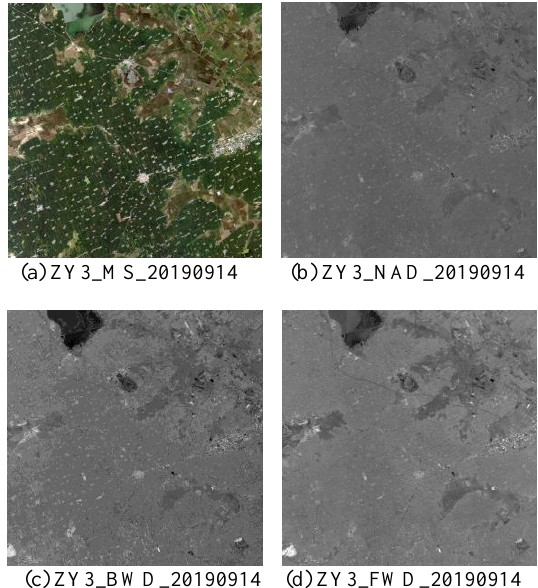
Figure 2. ZY-3 thumbnail images (20190914). (a) multi-spectral image; (b) panchromatic NAD image; (c) panchromatic BWD image; (d) panchromatic FWD image.